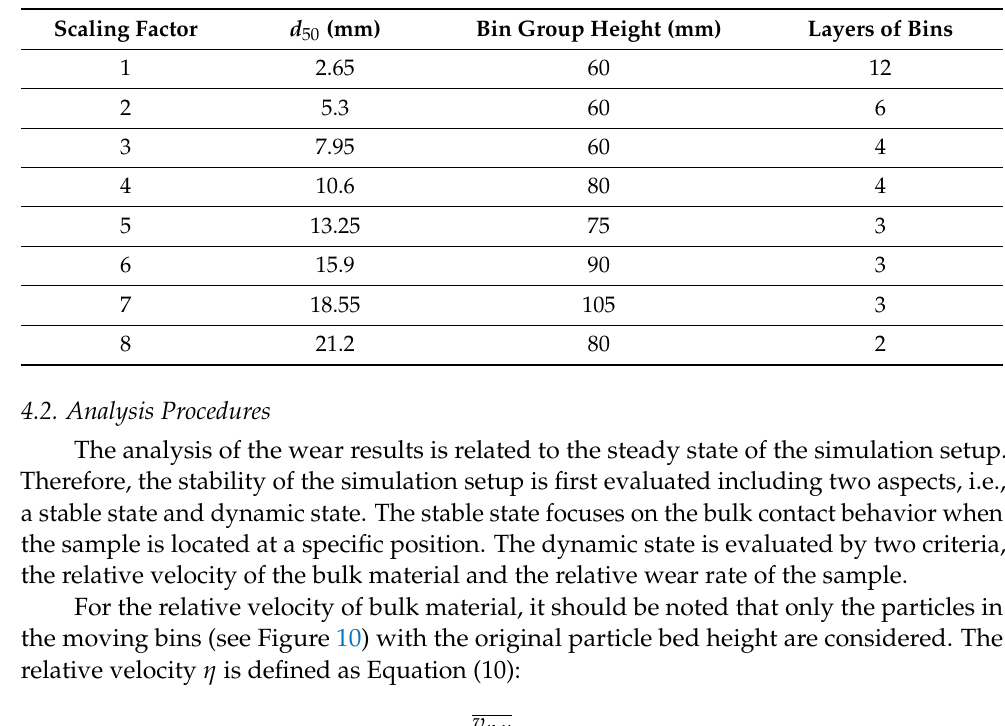
Table 2. Sizes and layers of the